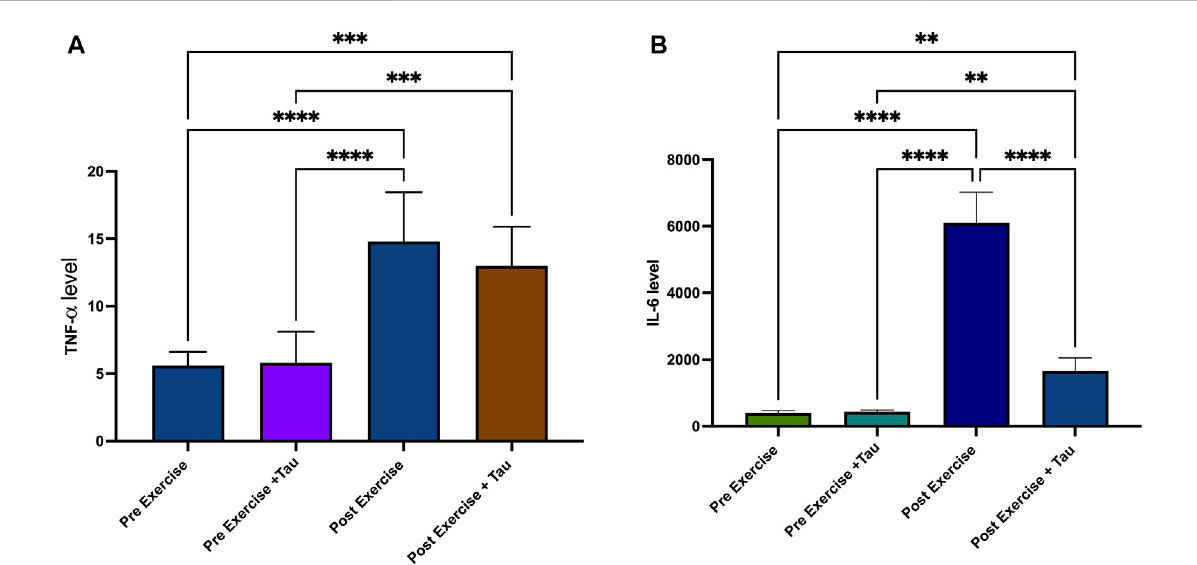
FIGURE 4 Effect of taurine on TNF-alpha and IL-6 levels. TNF-alpha level was increased in post-exercise and post-exercise + tau signi fi cantly when compared to pre-exercise and pre-exercise + tau (*** p < 0.05). TNF-alpha was decreased in post-exercise + tau when compared to